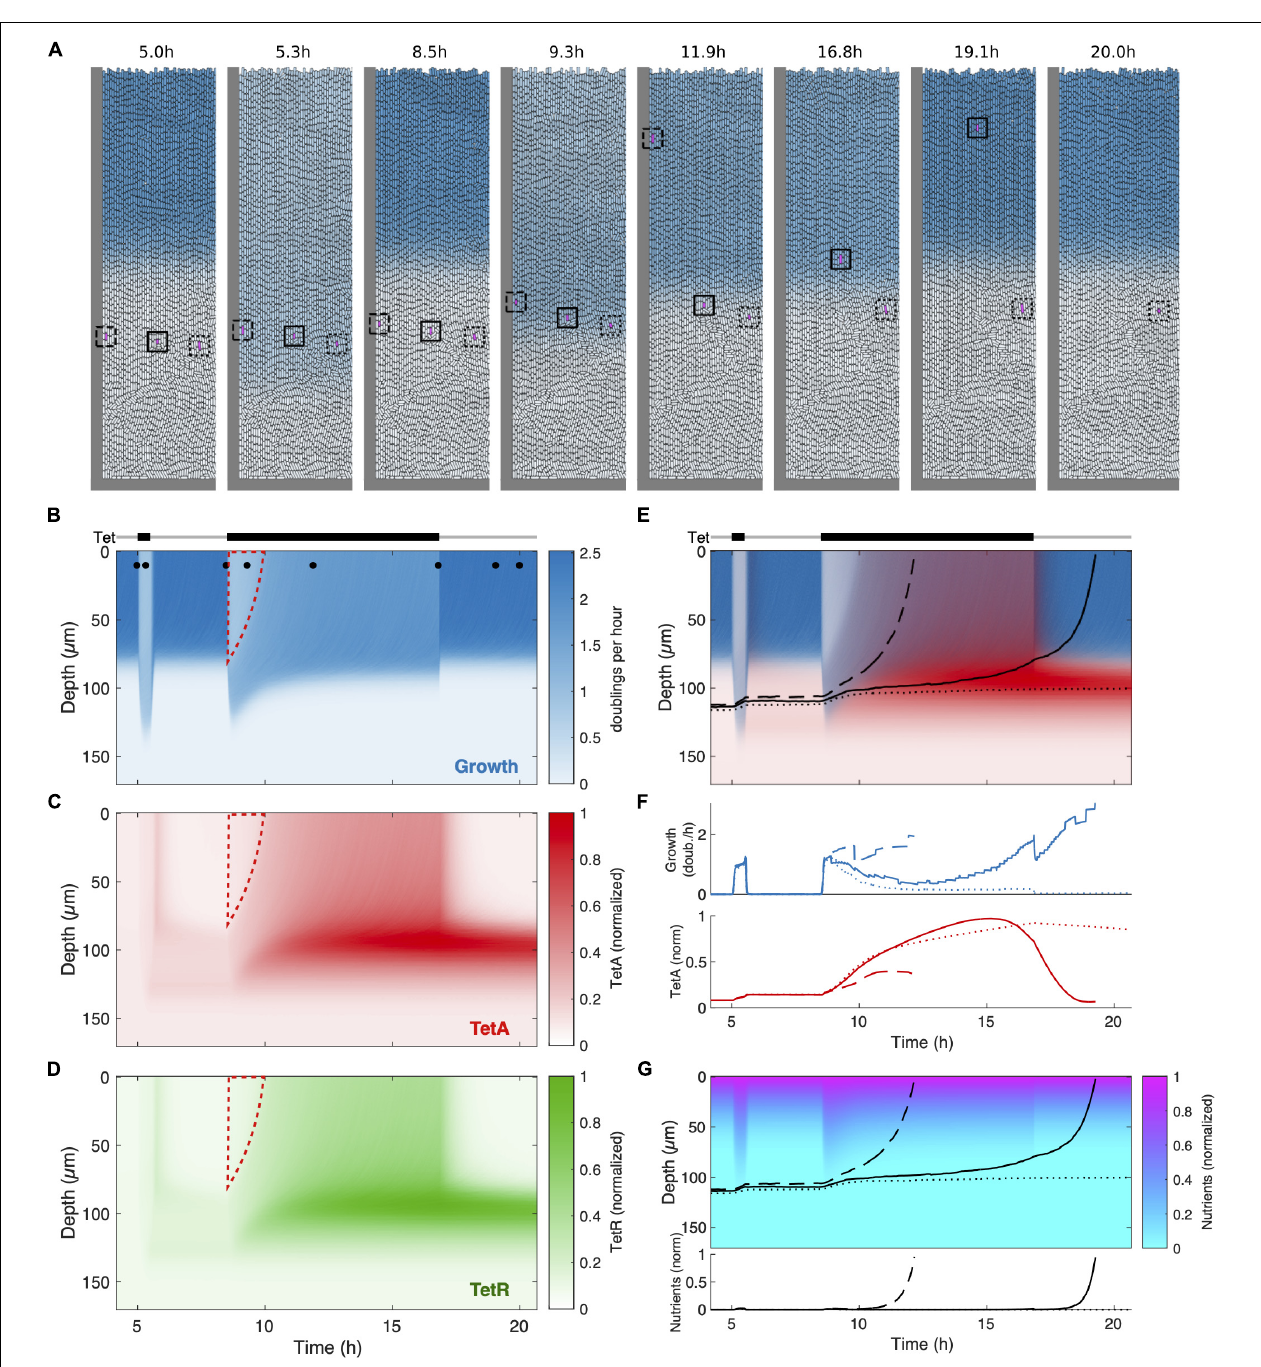
FIGURE 7 | Mathematical model recovers main features of colony dynamics during drug response. (A) Snapshots of agent-based simulations, showing transient reorganization by the growth pattern during a short drug pulse ( t = 5.3 h) and during a long pulse ( t = 9.3 h) eventually reaching a new drug-induced steady state ( t = 11.9 h), before returning to the original steady state after drug removal ( t = 19.1 h). Blue color indicates growth rate. Cells tracked to yield the trajectories in panel (E) and the time traces in panel (F) are enclosed by a square of the same line style. The full spatiotemporal dynamics can be seen in Supplementary Movie 2 . (B) Kymograph of the growth rate over the course of the simulation. Tet exposure is indicated above. Dots at the top of the kymograph indicate time points of the snapshots in panel (A) . Dashed red line marks the cells in the top (previously growing) part of the cell trap which are subsequently replaced by reactivated dormant cells already primed with TetA and TetR. (C,D) Kymographs as in panel (B) for TetA and TetR. (E) Superimposed kymograph of cell growth (blue) and TetA expression (red) with black lines indicating trajectories of three tracked cells (cf. panel A ). (F) Time traces of growth rate and TetA expression for the three tracked cells (cf. panels A,E ). (G) Kymograph of the nutrient concentration with black lines indicating the three cell trajectories. The corresponding time traces are displayed below the kymograph.